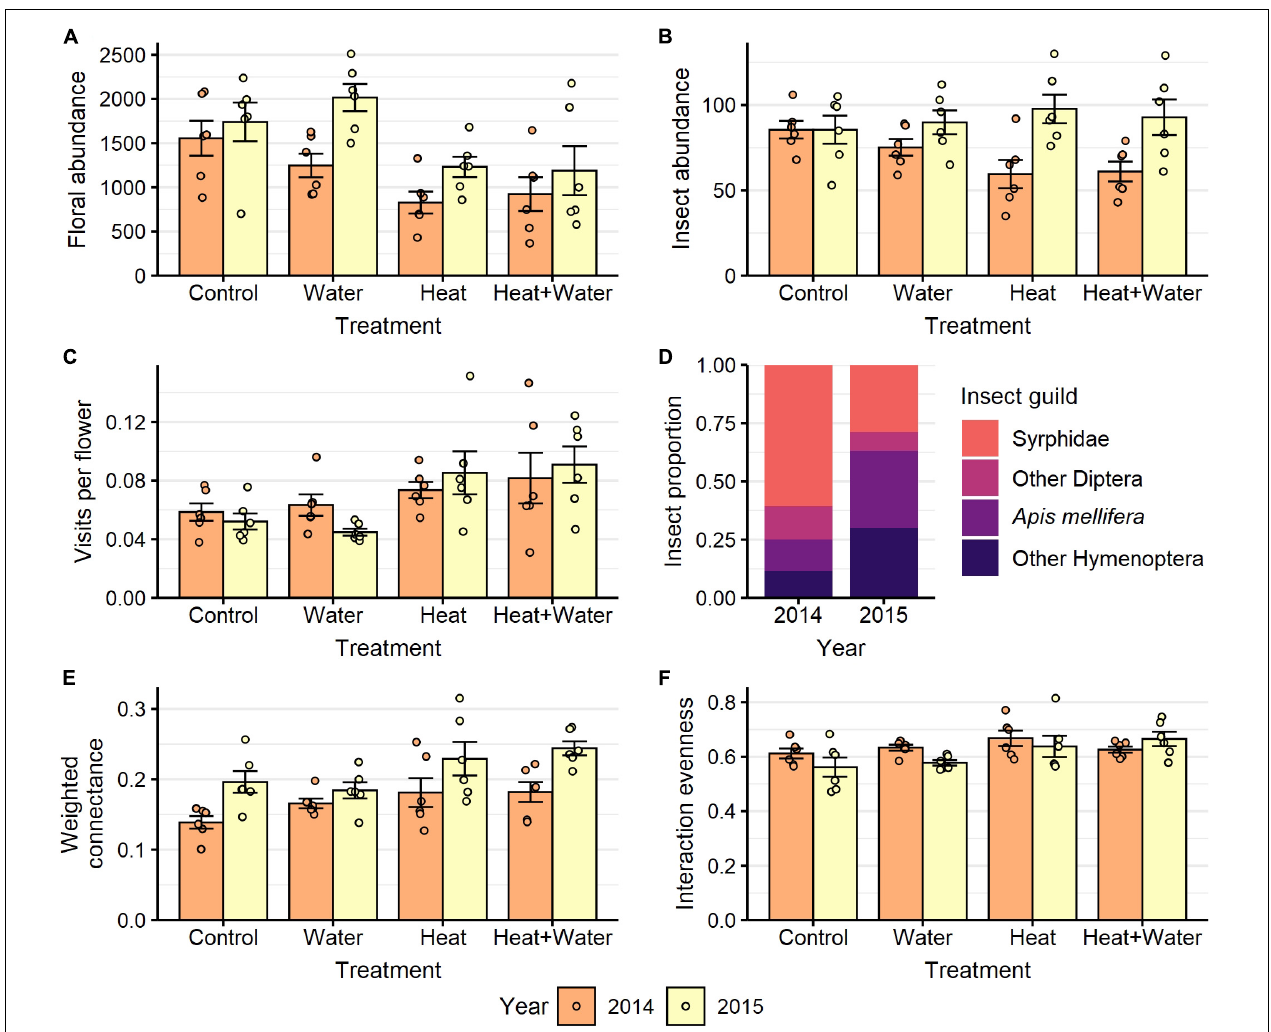
FIGURE 2 | Responses to treatment in each year for: (A) floral abundance, (B) flower-visiting insect abundance, (C) visits per flower, (E) weighted connectance, (F) interaction evenness. (D) Shows the proportion of visitors belonging to different insect guilds in each year. Bars and error-bars represent mean ± s.e. Points show the individual samples. n = 6 per treatment per year.